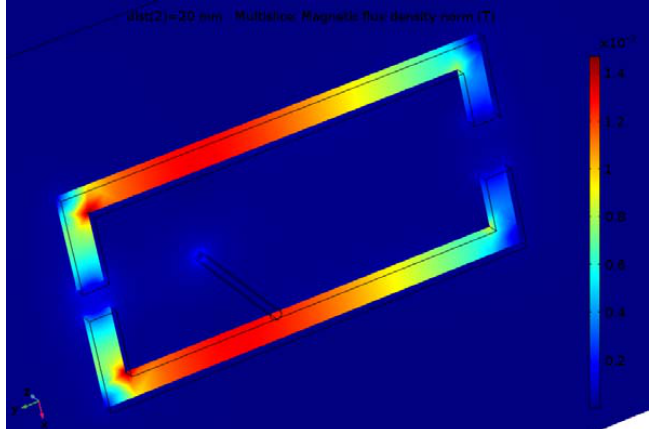
Figure 4. Flux density distribution for the construction with two air gaps.